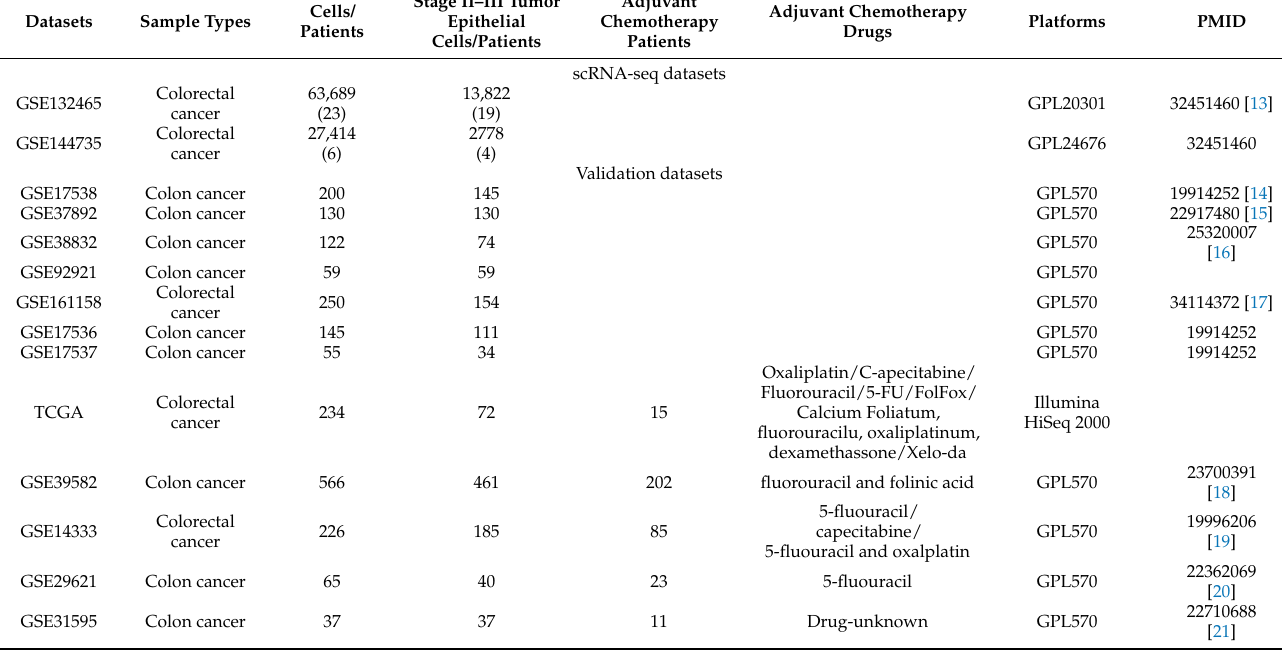
Table 1. Summary of scRNA-seq datasets and validation